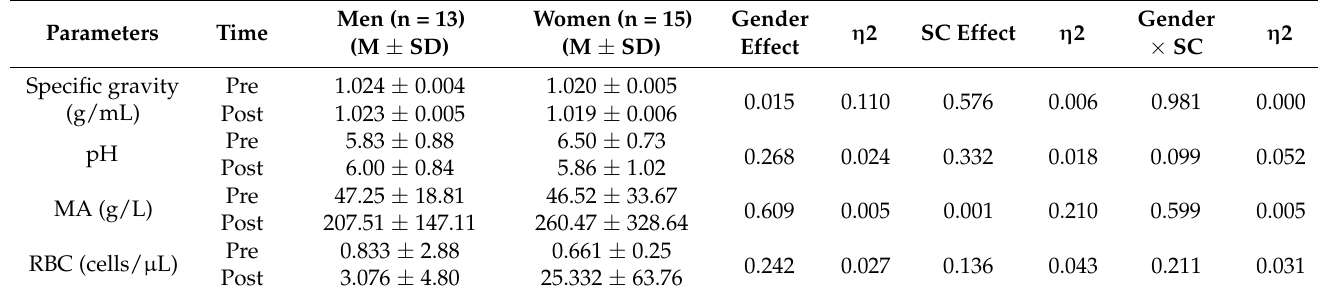
Table 5. Urinary parameters before and after CS in both groups.